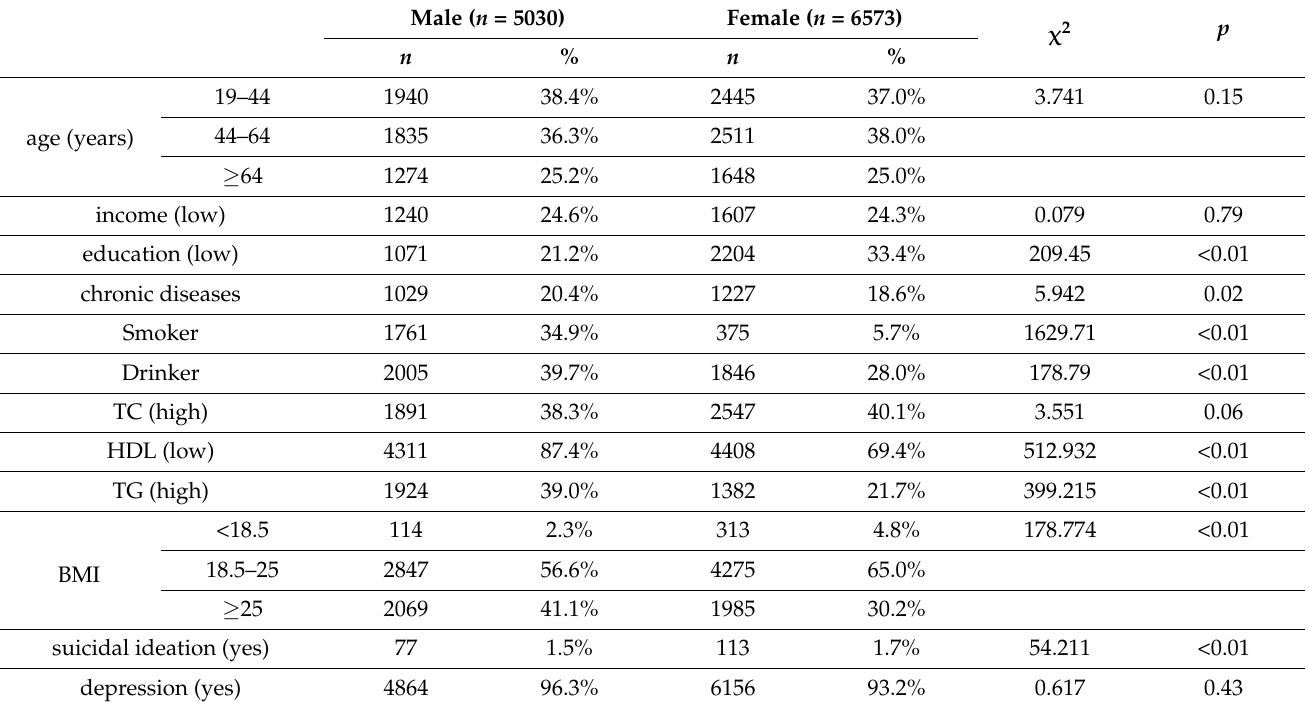
Table 2. Clinical characteristics according to